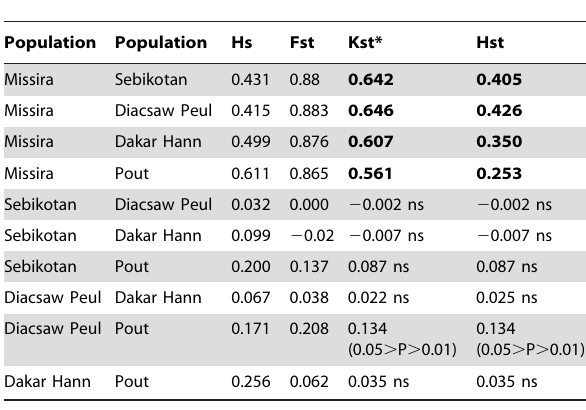
Table 1. Population differentiation statistics for mitochondrial cytochrome oxidase 1 ( COI ) sequences (738 sites in alignment, no